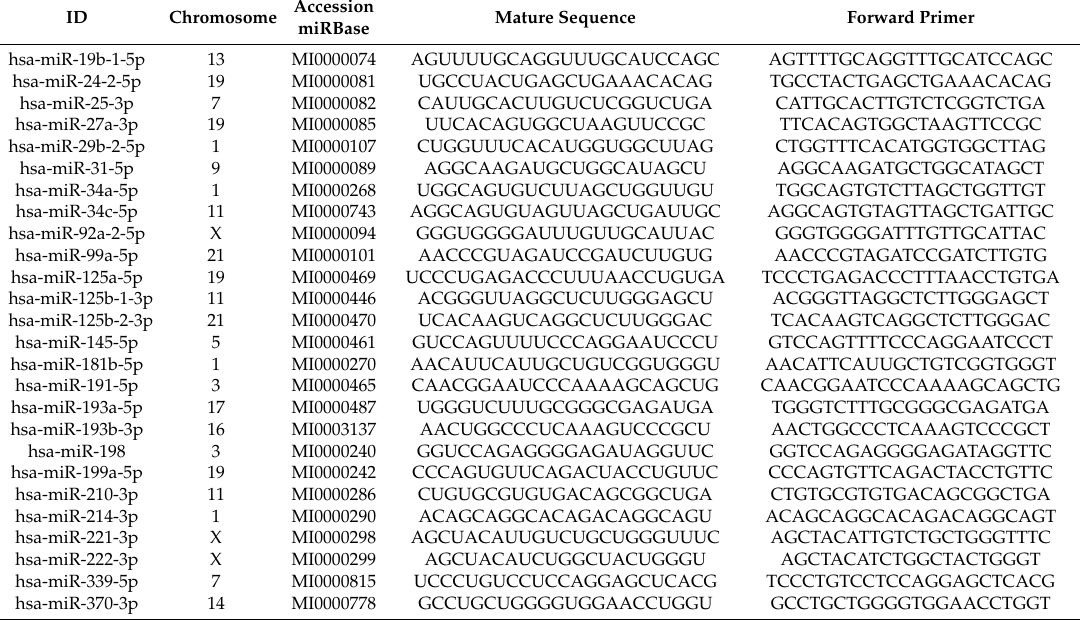
Table 1. Information about miRNA evaluated. ID, Chromosome localization, Accession miRBase (www.mirbase.org), Mature Sequence and Forward